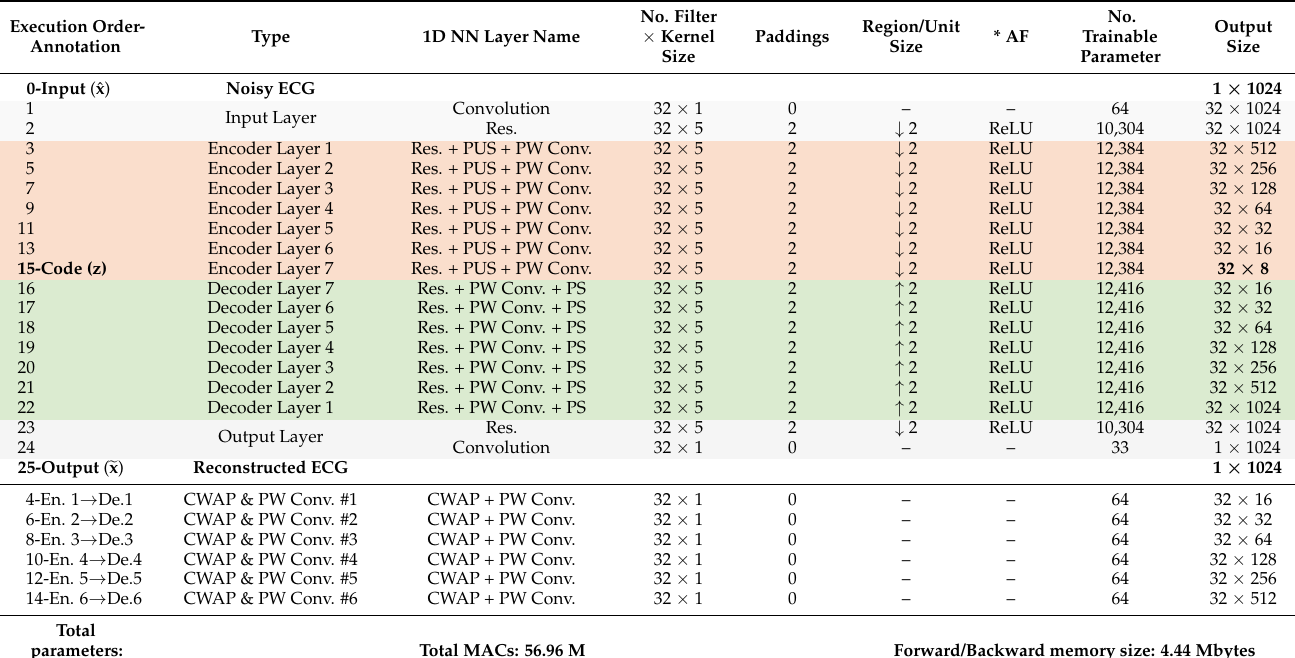
Table 2. Layer Information for the Regular Version of Proposed CPDAE.